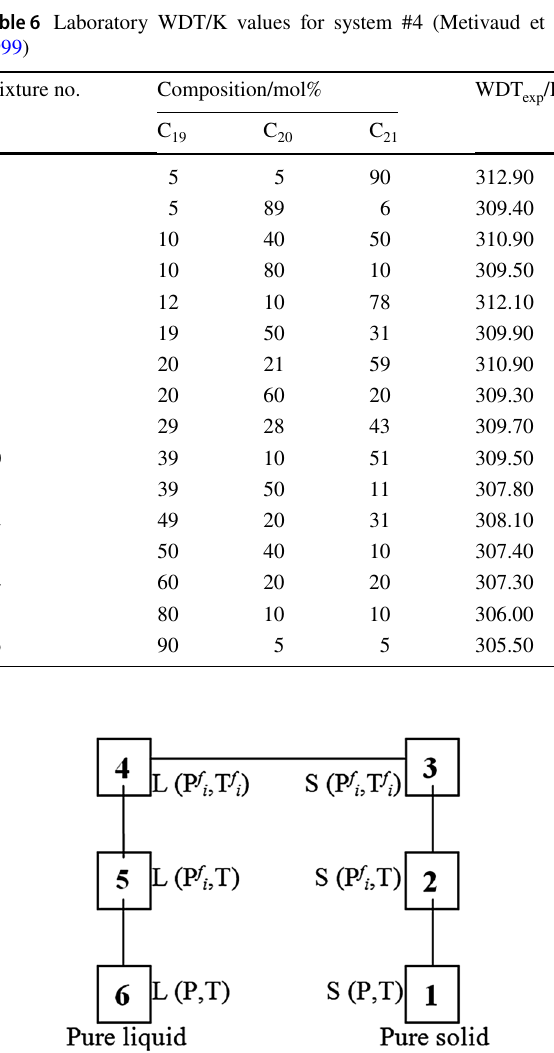
Fig. 2 Diagram for relating chemical potential of pure liquid